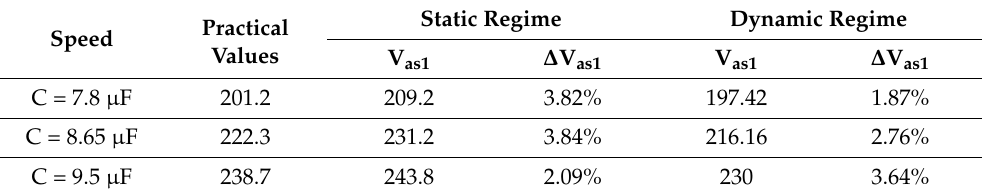
Table 3. Static and dynamic results at no load with N = 1500 rpm and variable